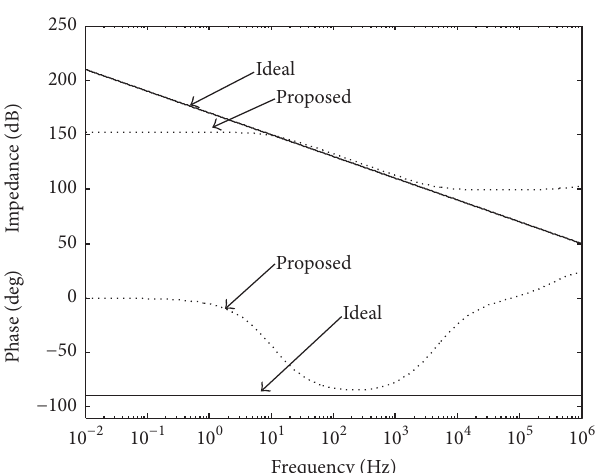
Figure 5: Compared impedance and phase for ideal and the proposed design.